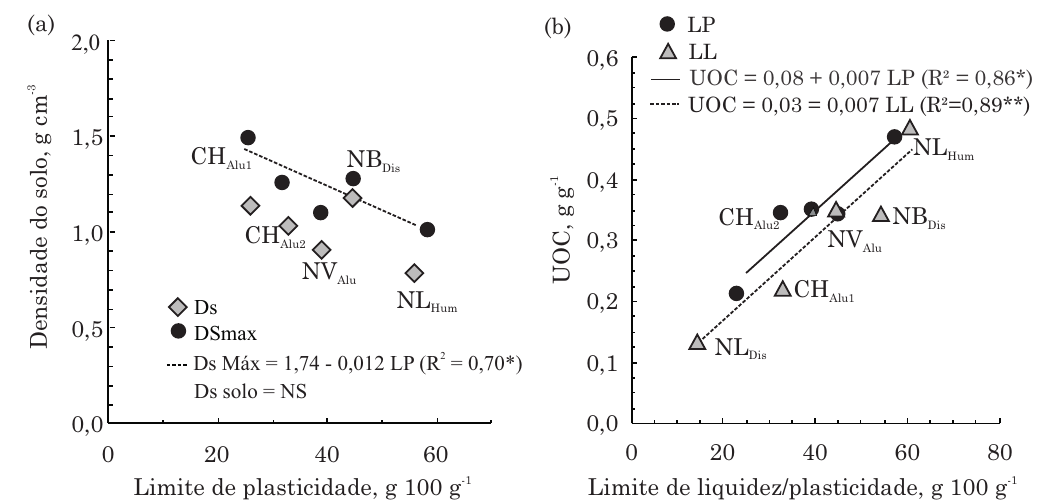
Figura 5. Relação entre o limite de plasticidade e a densidade máxima e densidade do solo (a) e entre os limites de plasticidade e liquidez e a umidade ótima de compactação (b) no horizonte A de seis solos do Planalto Sul Catarinense. CH Alu1 : Cambissolo Húmico alumínico 1; CH Alu2 : Cambissolo Húmico